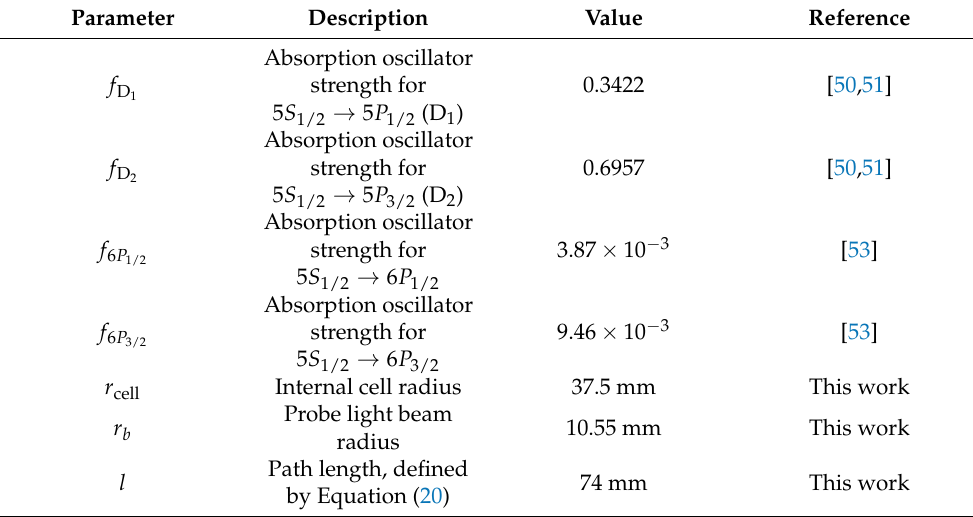
length, and the mean path length is 1.4% shorter than the maximum path length. Table 2. Absorption spectroscopy